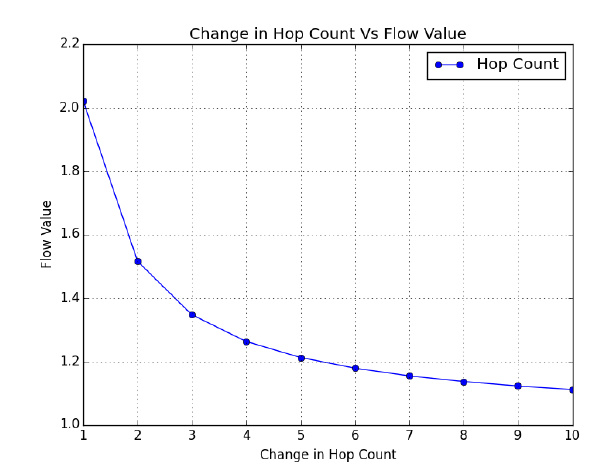
Figure 5. Change in Flow Value with change in Hop